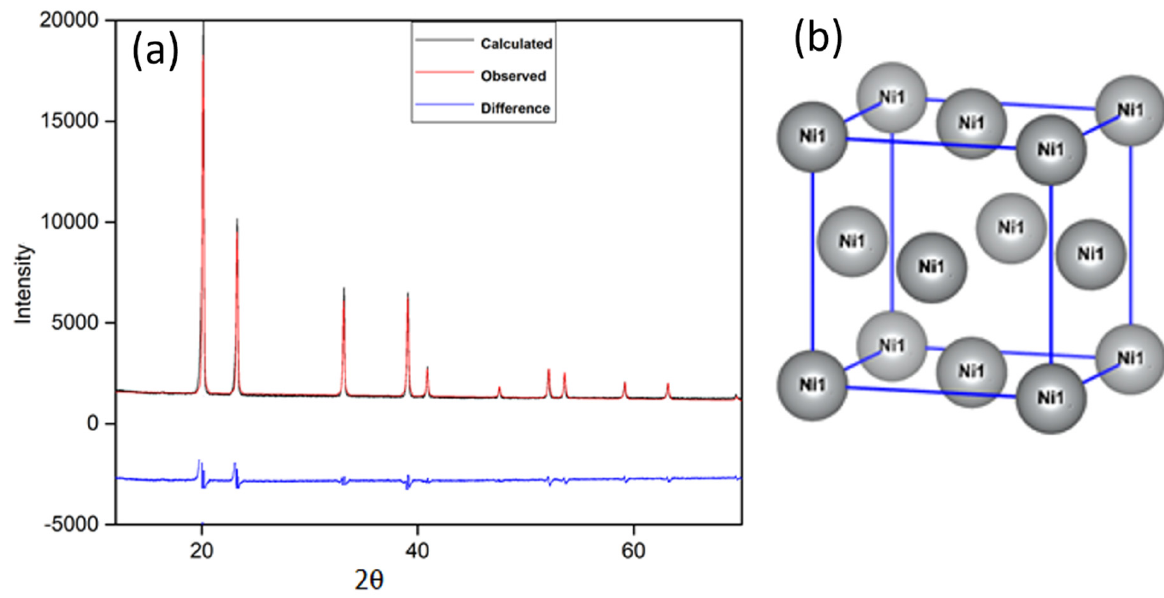
Figure 2 . ( a ) XRD patterns of Ni-NPs; ( b ) crystal structure of cubic Ni-NPs . Figure 2. ( a ) XRD patterns of Ni-NPs; ( b ) crystal structure of cubic